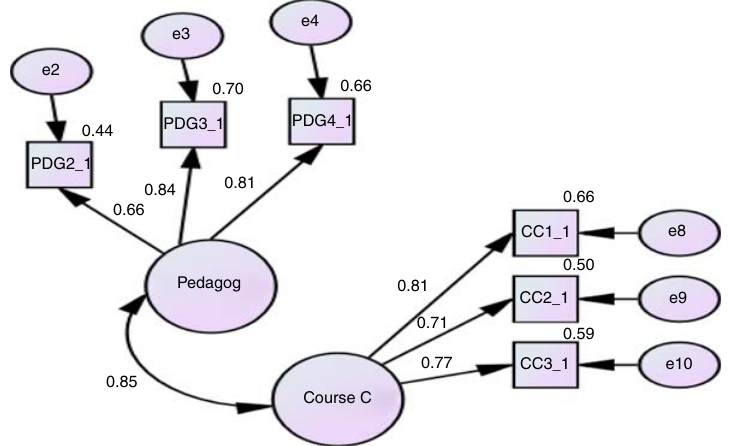
Figure 2. Measurement model for